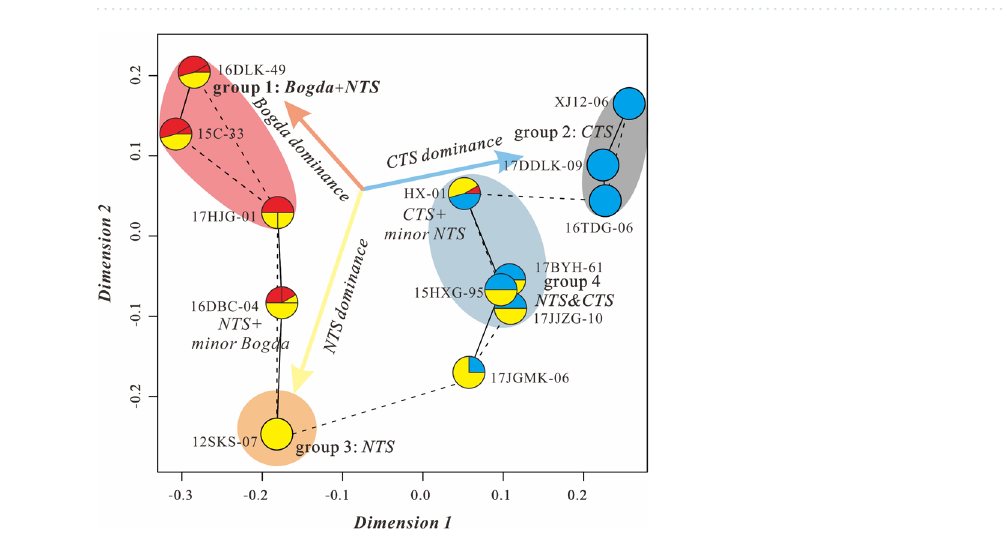
Figure 9. Multidimensional scaling plots (MDS) for detrital zircon U–Pb data of the samples from the Middle– Upper Triassic Xiaoquangou Group in different measured sections of the southern Junggar Basin 22 . Solid and dashed lines represent the closest and second closest neighbors, respectively. NTS, North Tianshan; CTS, Central Tianshan; Bogda, Bogda